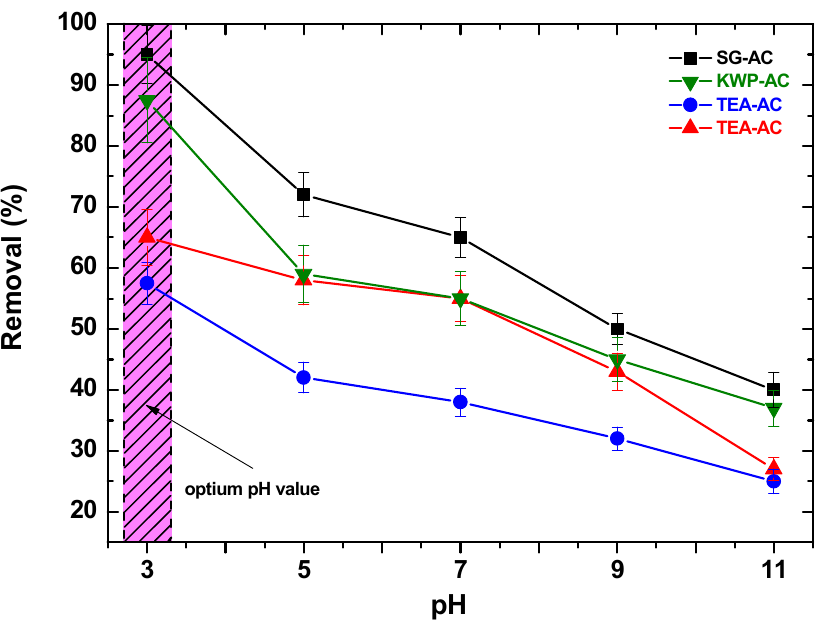
ORP-AC TEA-AC KWP-AC Figure 7. Yield (%) of the prepared AC samples. 3.2. Adsorption Evaluation